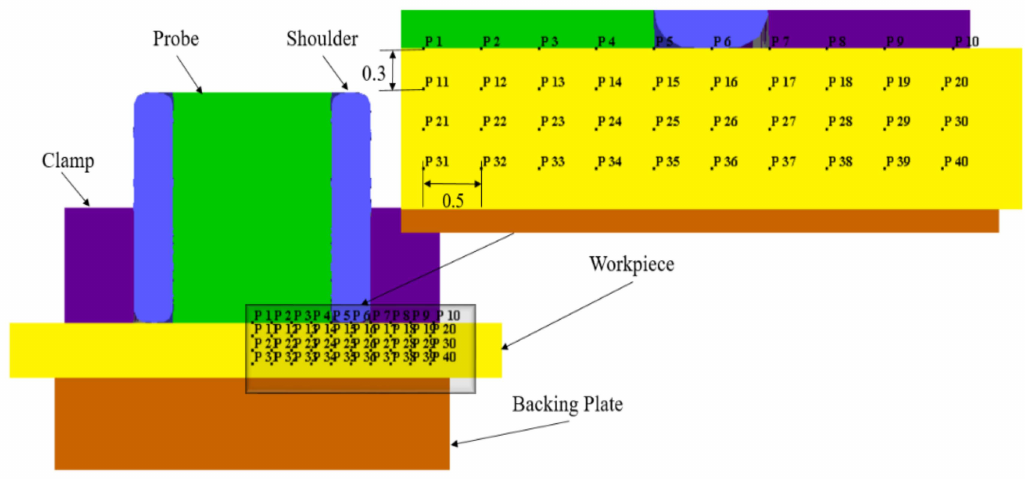
Figure 11. The initial position of points from the point tracking option that have been selected for studying the material